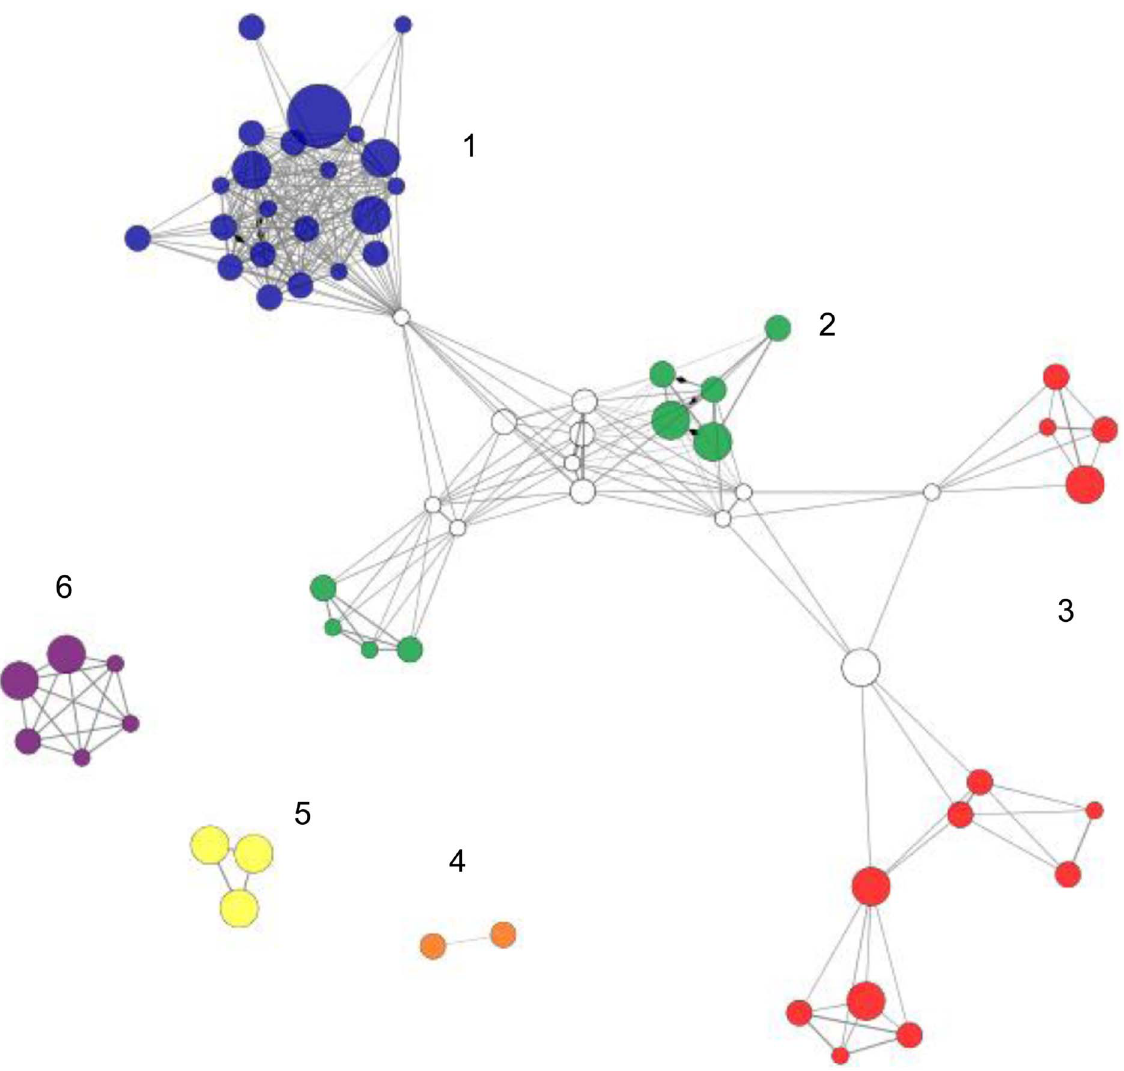
Figure 3. Networks of E2-regulated genes. ClueGO analysis classified the 88 E2-regulated genes into 6 networks. White nodes indicate that a biological process is associated with two networks. Node size indicates the statistical significance of the biological process represented. Thus, larger nodes indicate greater statistical significance.